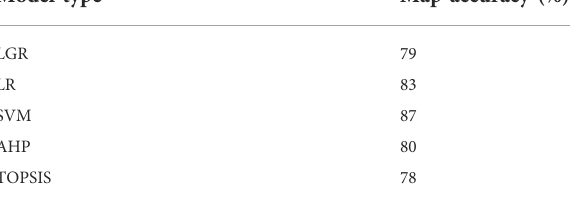
TABLE 6 Accuracy assessment of produced landslide susceptibility maps. Model